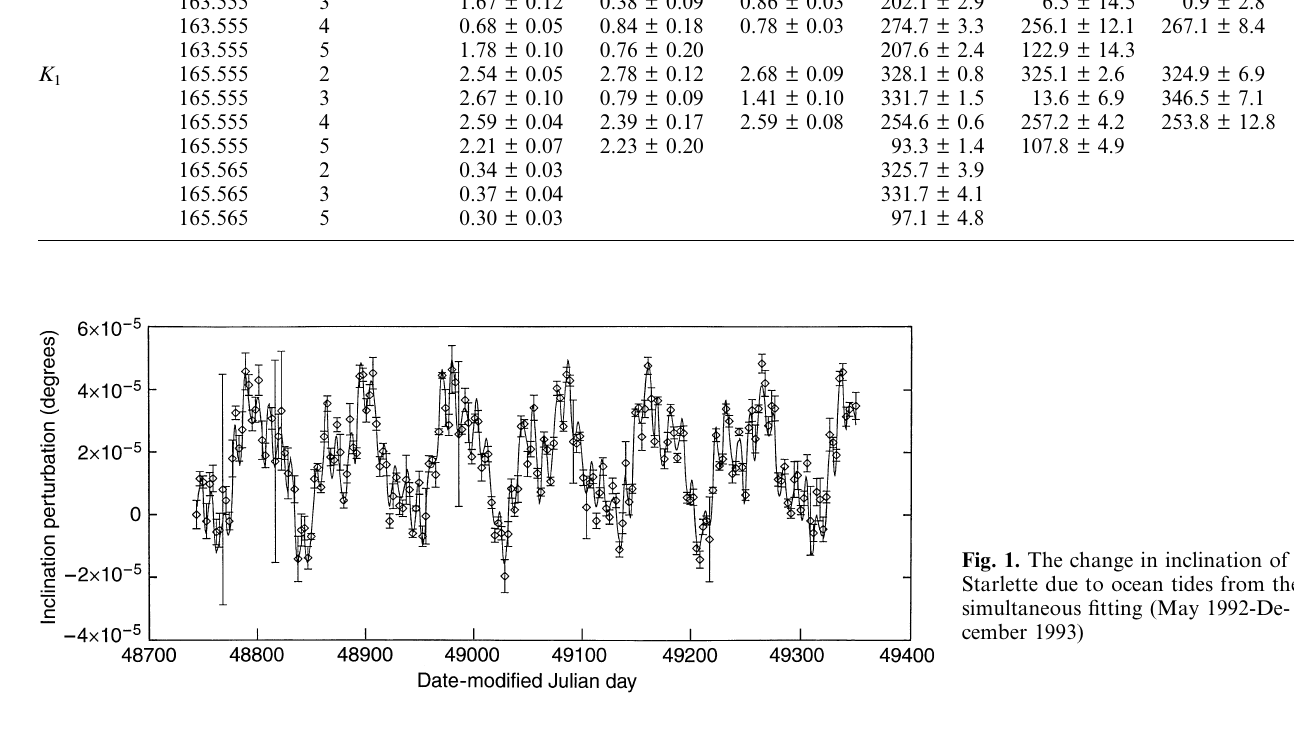
Fig. 1. The change in inclination of Starlette due to ocean tides from the simultaneous fitting (May 1992-De- cember 1993)